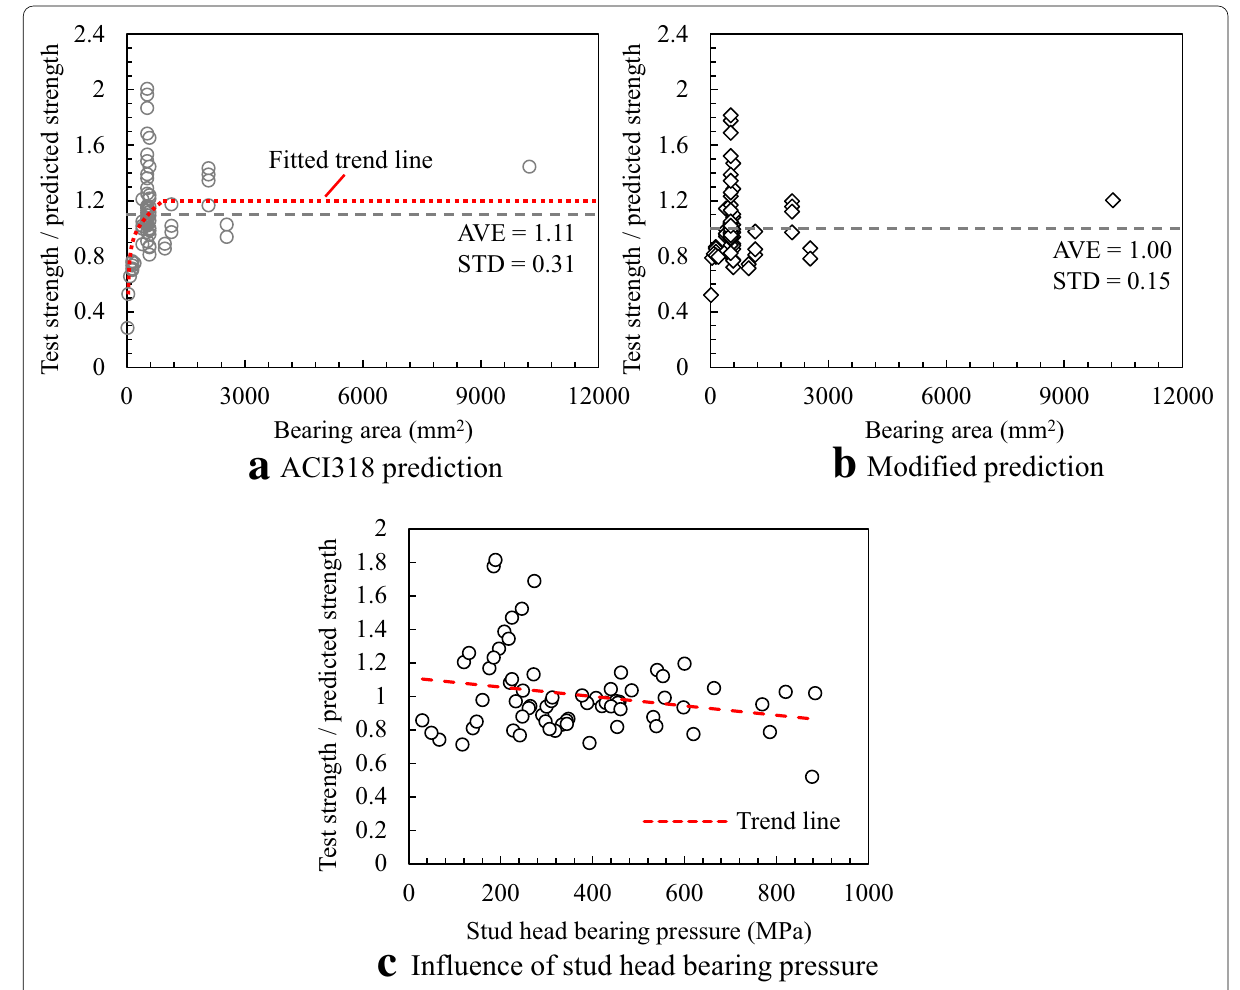
Fig. 15 Influence of bearing area on the concrete anchorage